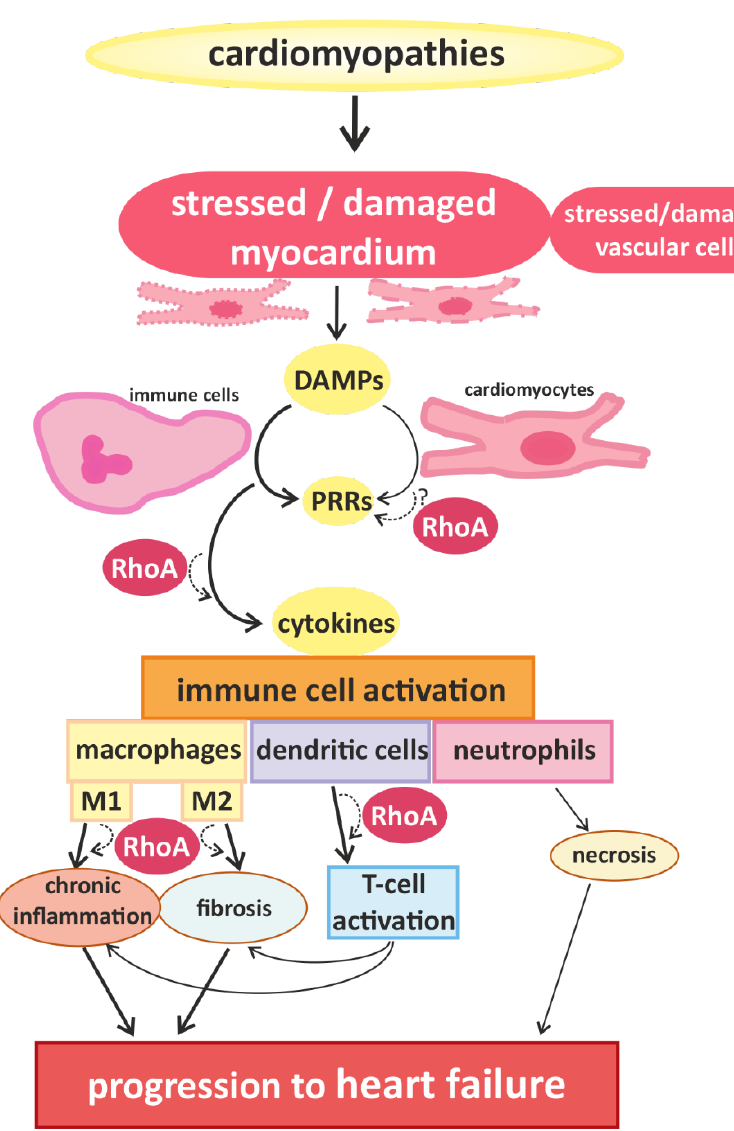
Figure 1. Cardiomyopathies of different causality converge in myocardial damage, inducing immune cell responses and promoting disease progression. Cardiomyocytes and blood vessel cells that are stressed or injured release danger signals with “danger-associated molecular patterns” (DAMPs), which are recognized by “pattern recognition receptors” (PRRs), expressed by immune cells and cardiomyocytes. The activation of PRRs induces the migration and activation of (more) immune cells via cytokine signaling. In damaged myocardium, classically activated M1-type and alternatively activated M2-type macrophages are found, which are associated with chronic inflammation and fibrosis, respectively. Furthermore, dendritic cells and co-stimulated T-cells contribute to the development of inflammatory and fibrotic remodeling. Infiltrating neutrophils are associated with increased necrosis. These processes accelerate the progression of cardiac dysfunction. RhoA-dependent signaling is essential for effective immune cell activation and might also play a role in the transduction of danger signals and receptor activation in cardiomyocytes. In addition RhoA signaling is involved in macrophage polarization and signaling pathways mediating the interaction between dendritic cells and T-cells, contributing to pro- and anti-inflammatory remodeling and finally, heart failure.